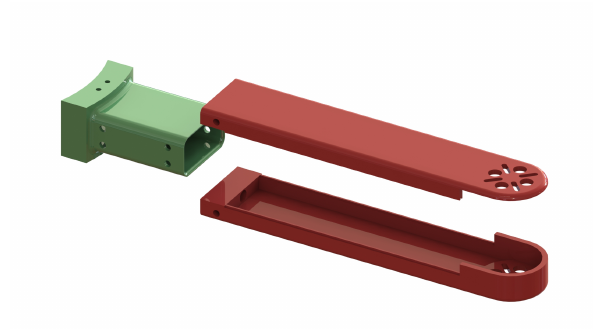
Figure 4: Box shaped arm and telescopic mechanism.